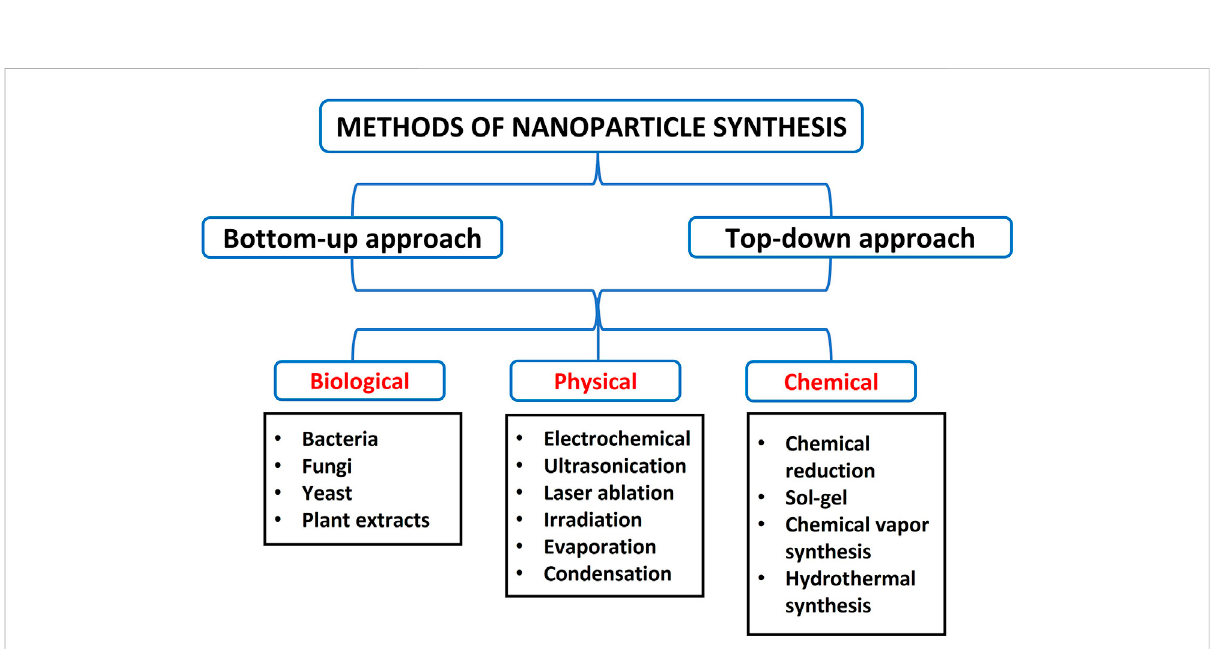
FIGURE 3 Summary of different methods of synthesising